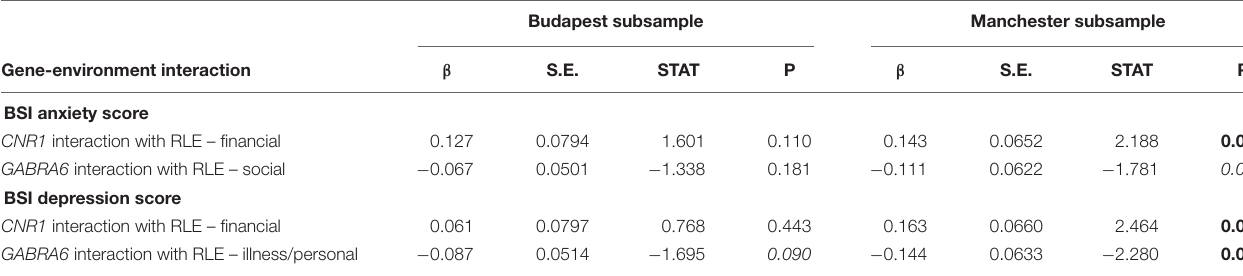
FIGURE 4 | Significant interaction effect of illness/personal problems and GABRA6 rs3219151 on current depression scores in the total sample. Mean BSI depression scores are displayed with standard error bars, in function of genotype and the number of life events related to illness, injury or problems occurred within the last year (general linear model performed only for visualization purposes). TABLE 4 | Re-analysis of data split according to study site in the Budapest and Manchester